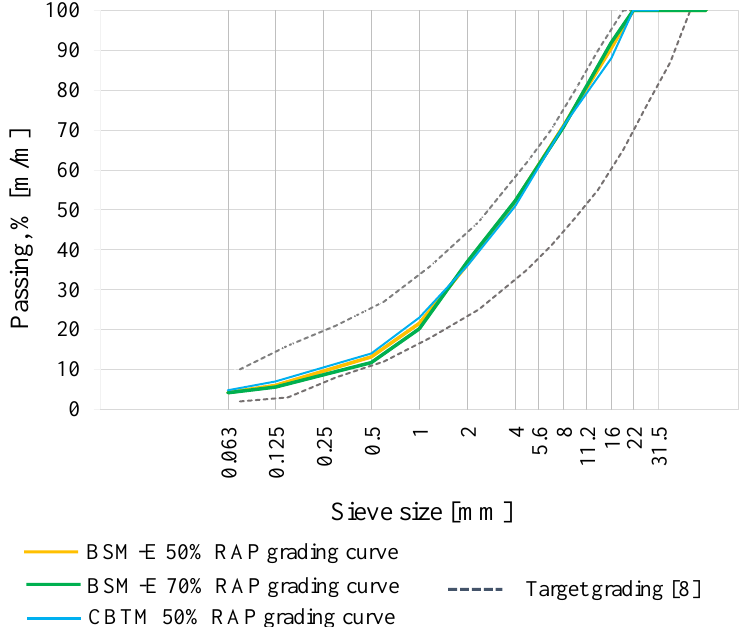
Figure 1. Bitumen-stabilized materials with bitumen emulsion (BSM-E) and cement–bitumen-treated material (CBTM) grading curves with target grading [8].